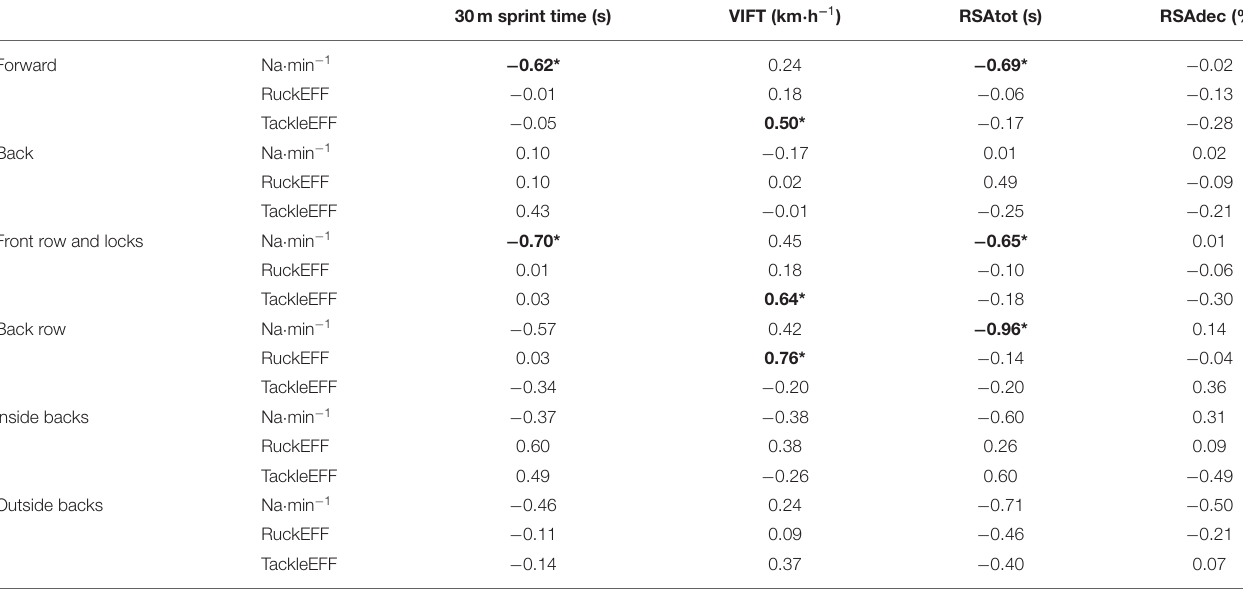
TABLE 2 | Relationships between physical abilities and technical performance in matches according to